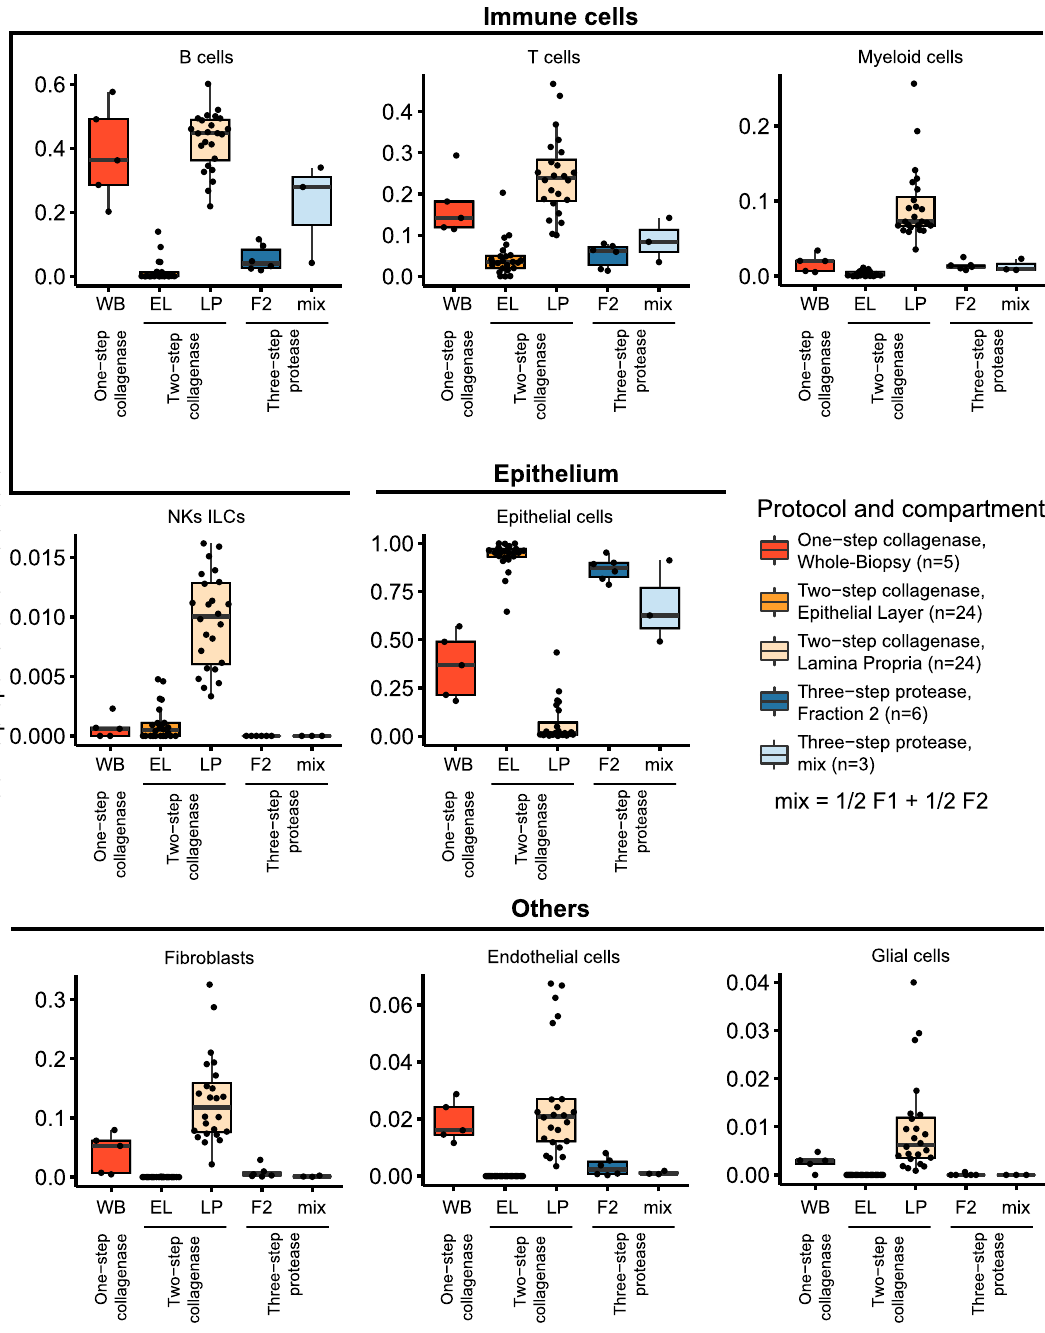
The immune cells (myeloid cells, B and T lymphocytes) revealed mostly similar numbers of DE genes between the one-step collagenase protocol and the multi-step protocols, except for the B cells. In these cells we observed a large discrepancy in the number of upregulated versus downregulated genes in the one-step collagenase versus multi-step protocols; 976 genes are downregulated in the two-step versus the one-step collagenase protocol, whereas 90 genes are upregulated (Suppl. table 3a). Remarkably, myeloid and B cells show the highest proportion of collagenase-induced genes upregulated in the one-step collagenase as compared to the three-step protease protocol (27% and 25%, respectively) (Suppl.